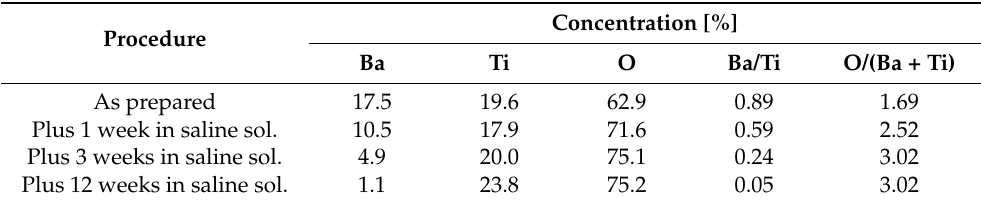
Table 2. Relative concentrations of elements contained in BaTiO 3 films, determined by XPS, and Ba/Ti and O/(Ba + Ti) concentration